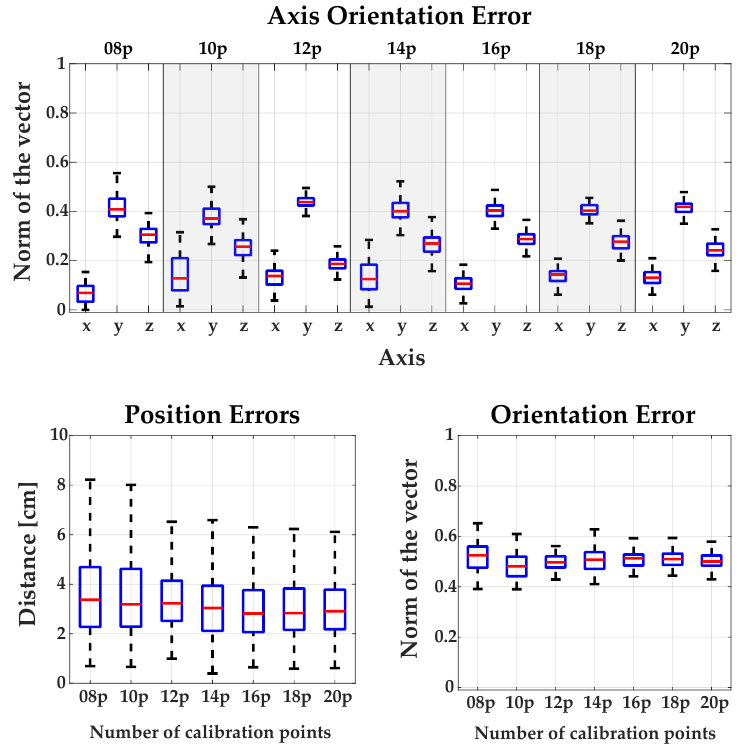
Figure A2. Results obtained by the standard calibration method using different numbers of calibration points.